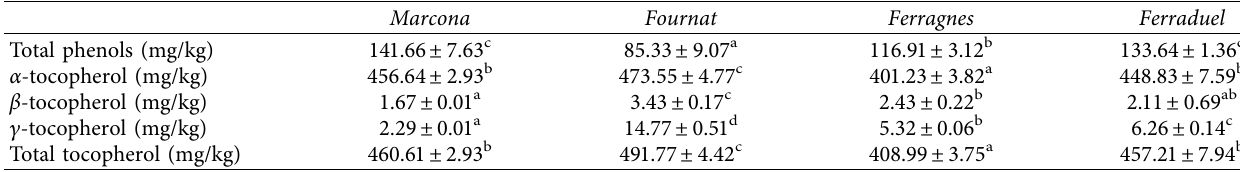
Table 2: Total phenol and tocopherol composition of four almond oil varieties produced in eastern